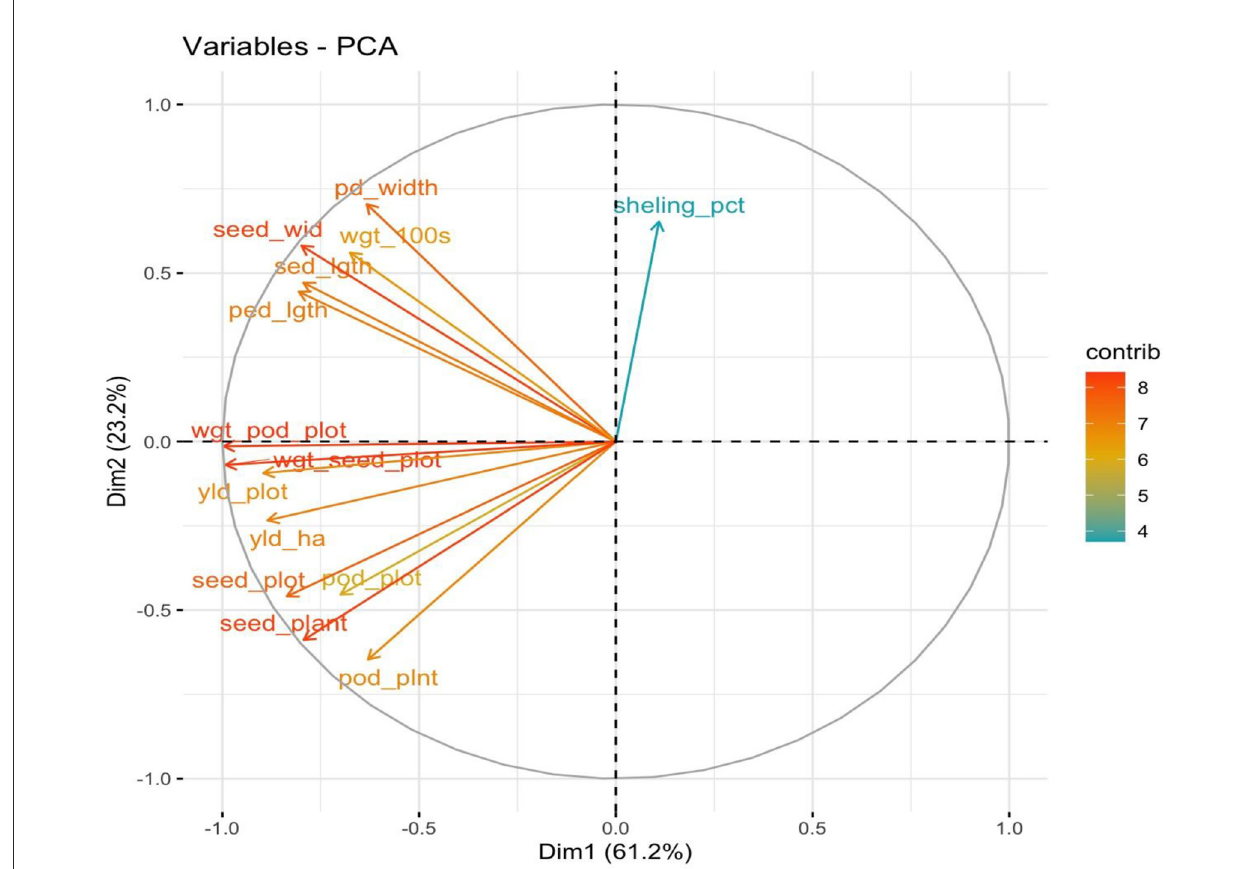
FIGURE3 Principal components analysis (PCA) showing the yield traits of BGN